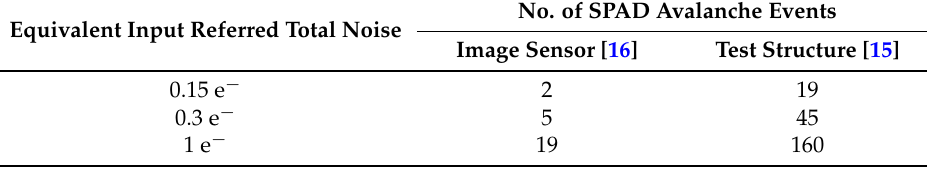
Table 2. Equivalent noise at a range of SPAD events.